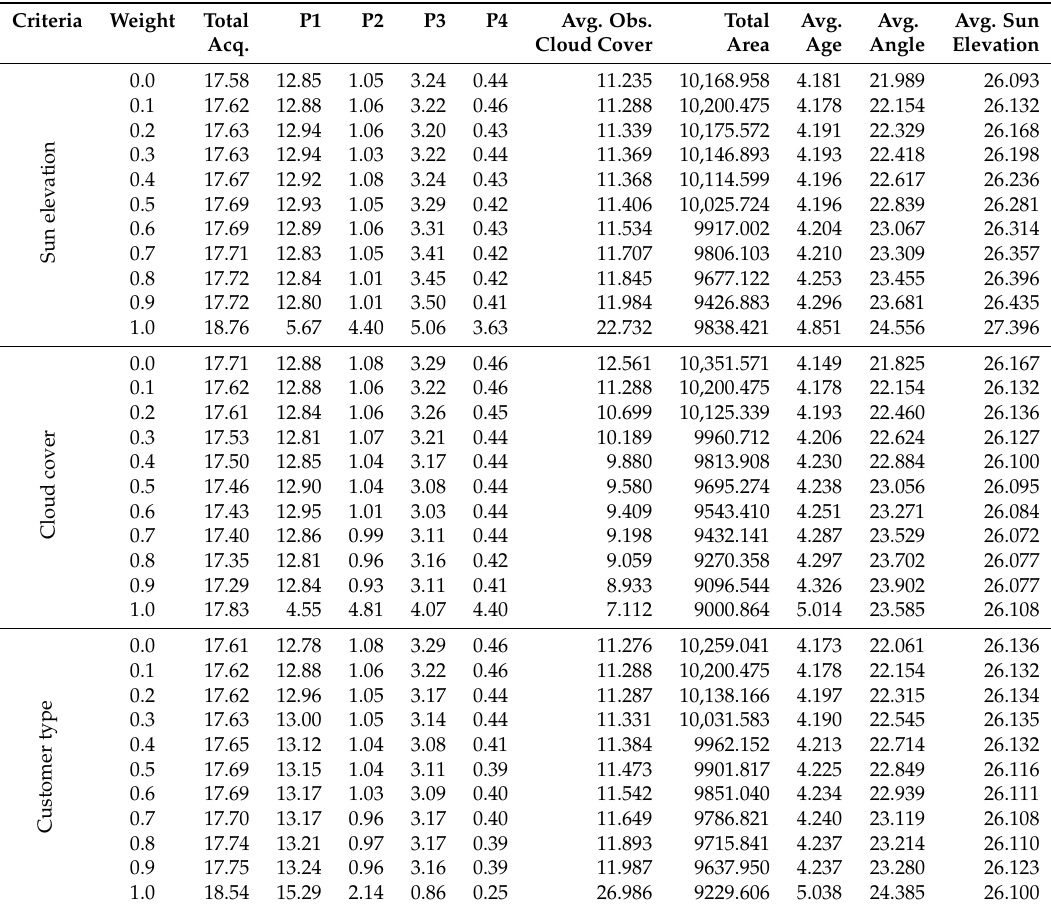
Table 6. This is the average performance measures for 100 generated scenarios, where the scoring through Elimination and Choice Expressing Reality (ELECTRE-III) has been conducted with different criteria weight settings. Note that the threshold values are fixed, and as the criteria weights are dependent by the sum to one constraint, this table illustrates the performance change of modifying the importance of a single criteria weight relative to all